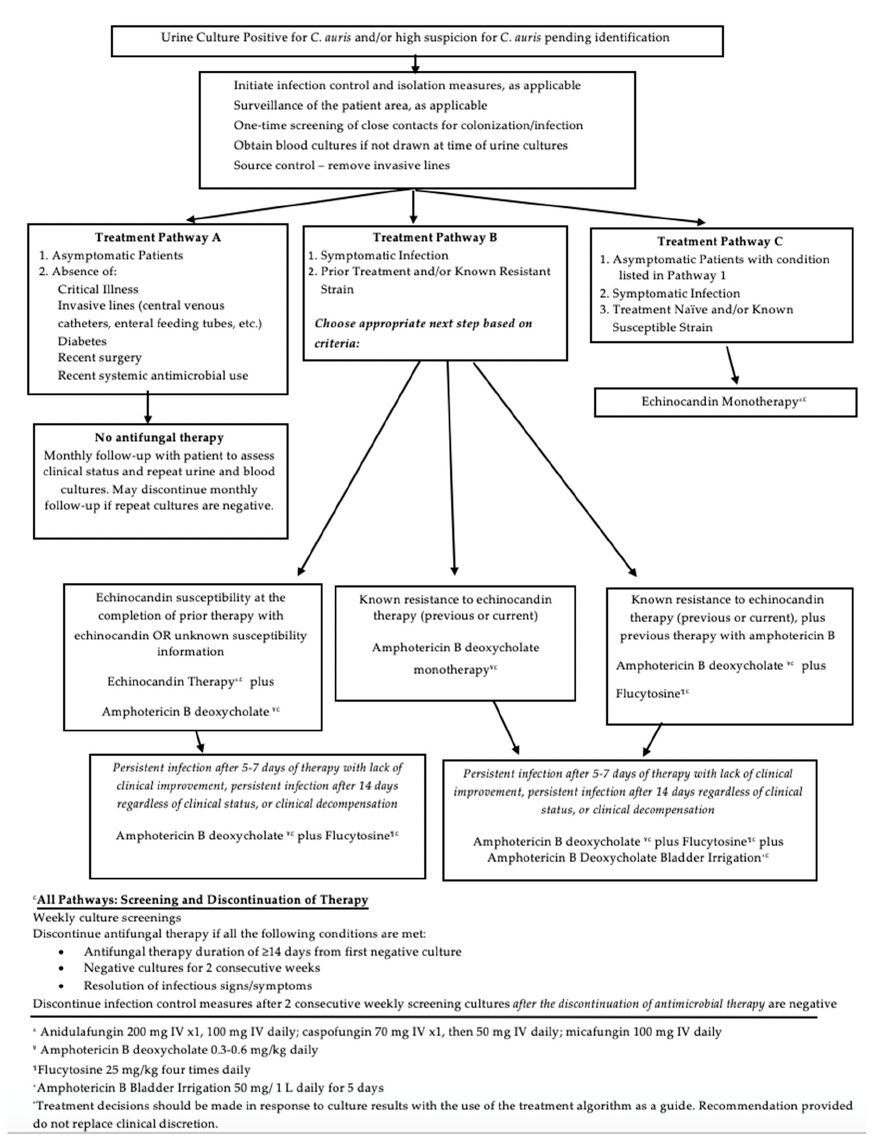
Figure 1 . Treatment algorithm for Candida auris UTIs . Figure 1. Treatment algorithm for Candida auris